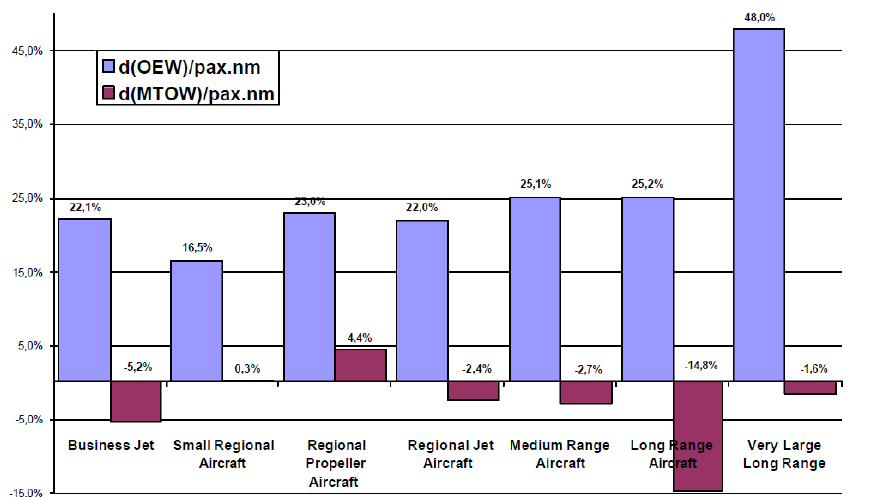
Figure 19. Changes in the operating empty weight and maximum take-o ff weight for an LH 2 powered Figure 20. Changes in the operating empty weight and maximum take-off weight for an LH 2 powered aircraft as compared to equivalent kerosene-fueled aircraft. aircraft as compared to equivalent kerosene-fueled aircraft. [36].